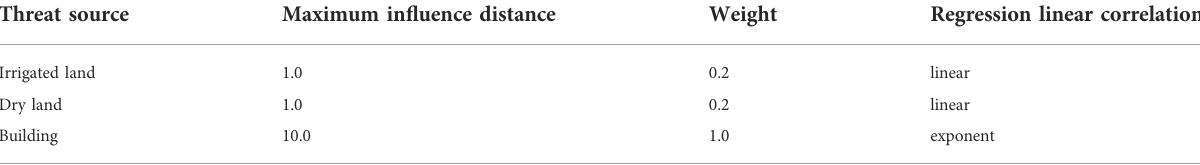
TABLE 2 Weight and maximum in fl uence distance of threat sources.